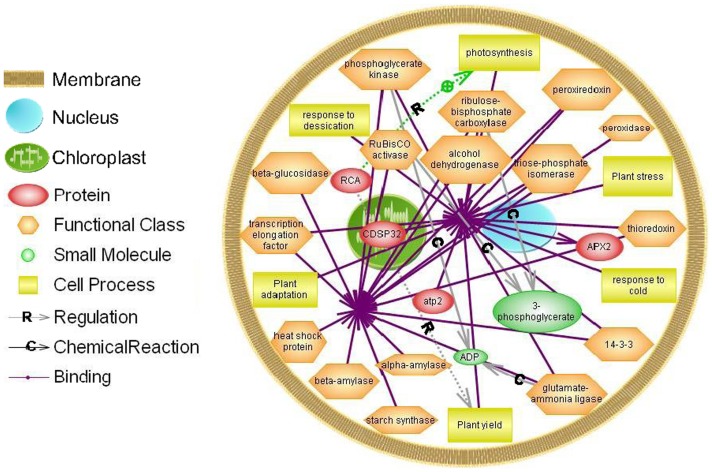
Biological networks generated for combination of twelve differential proteins.Fifteen differentially up-regulated proteins including ATP synthase subunit beta, alcohol dehydrogenase, beta-glucosidase, phosphoglycerate kinase, triose phosphate isomerase, RCA, Rubisco, APX2, CDSP3, peroxiredoxin, thioredoxin translation elongation factor, glutamate-ammonia ligase, chaperone and 14-3-3 in cassava autotetraploid genotypes were used to generate a protein-protein interaction network through Pathway Studio analysis. Regulation is marked as an arrow with R, Chemical Reaction as an arrow with C and Binding as an arrow without any marks. The entity table, relation table and reference table data were presented in in Tables S1, S2, S3.